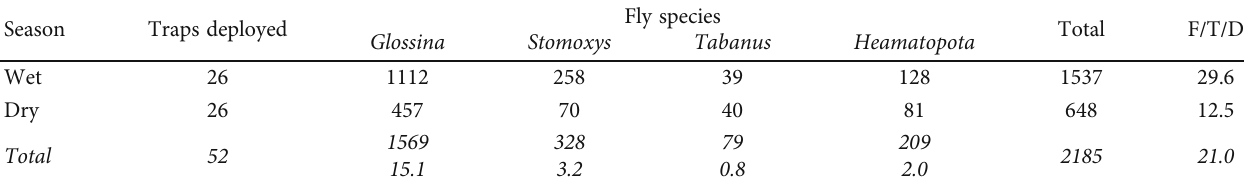
Table 6: The overall apparent density of fl y during di ff erent seasons in the study area.